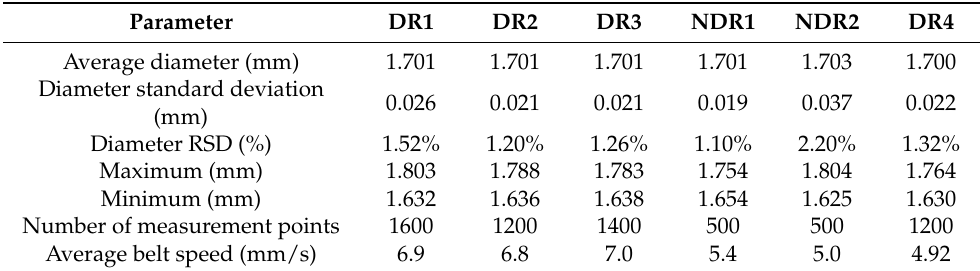
Table 8. Summary table of stericut analysis.